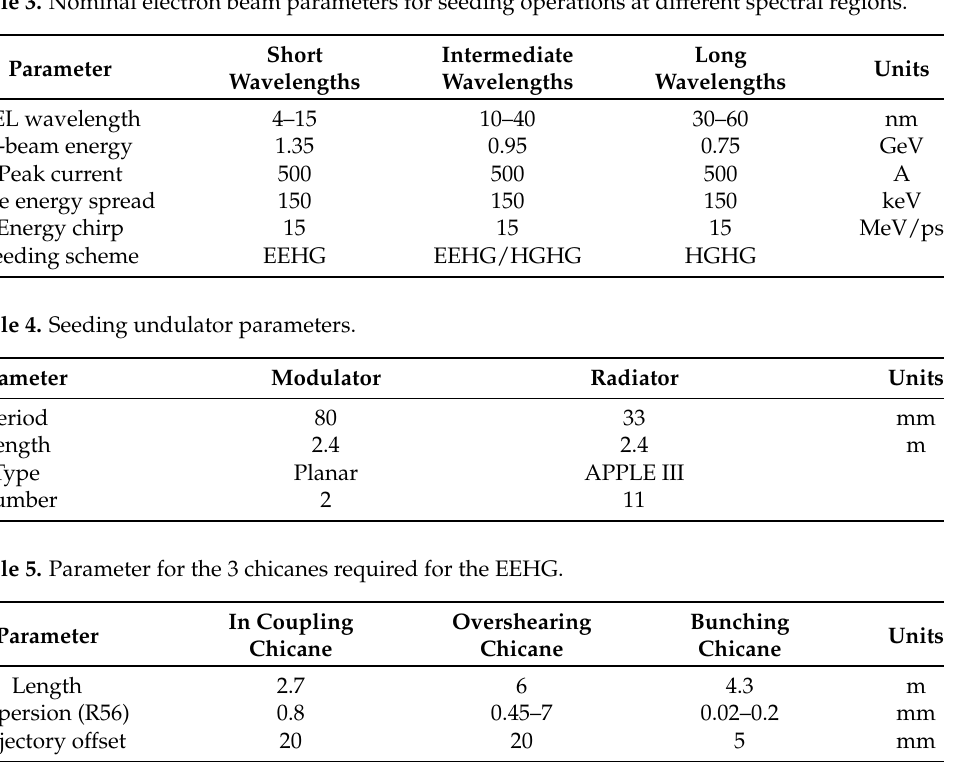
Table 3. Nominal electron beam parameters for seeding operations at different spectral regions.